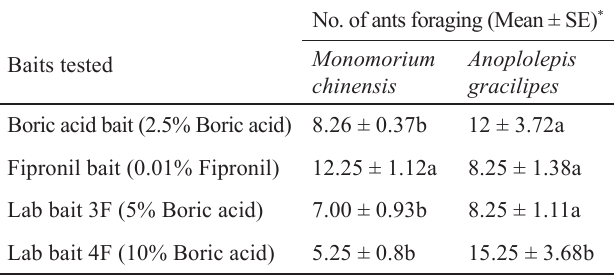
Table 2 . Preference of Monomorium chinensis and Anoplolepis gracilipes on new fructose and commercial baits under laboratory conditions.